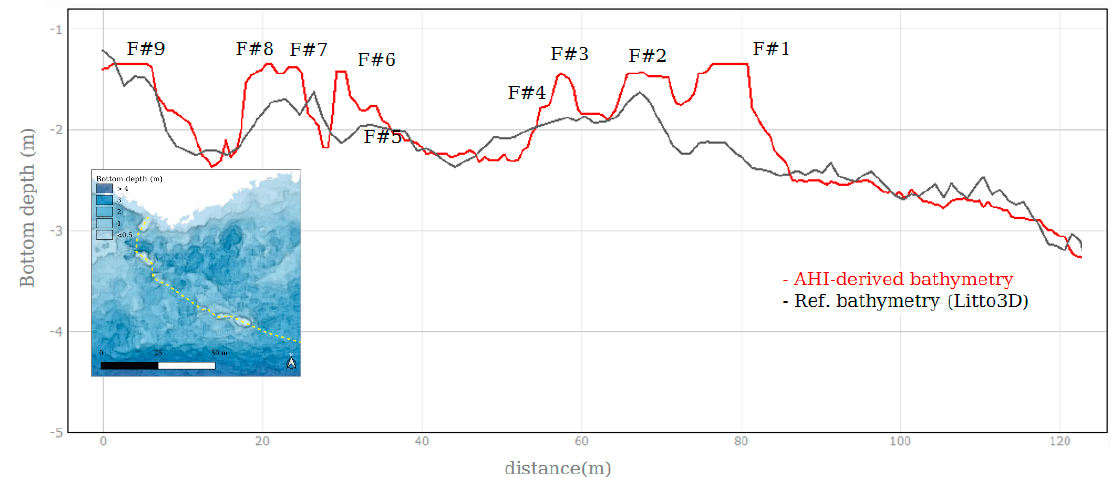
Figure 10. Path profile of bottom depth estimated from airborne hyperspectral imagery (AHI) and reference Litto3D (Shom / IGN) bathymetric data over the submerged structures.